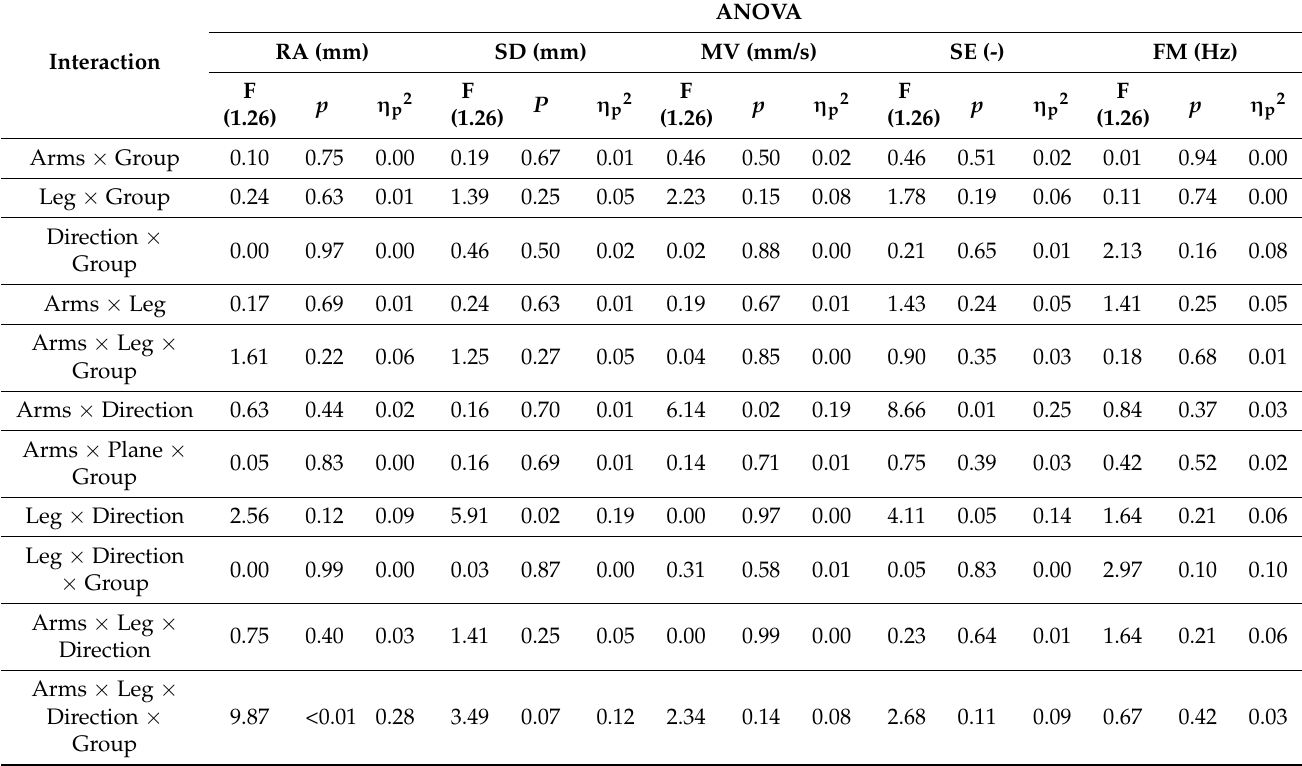
Table 4. Interactions in the analysis of variance ( η p2 , partial eta